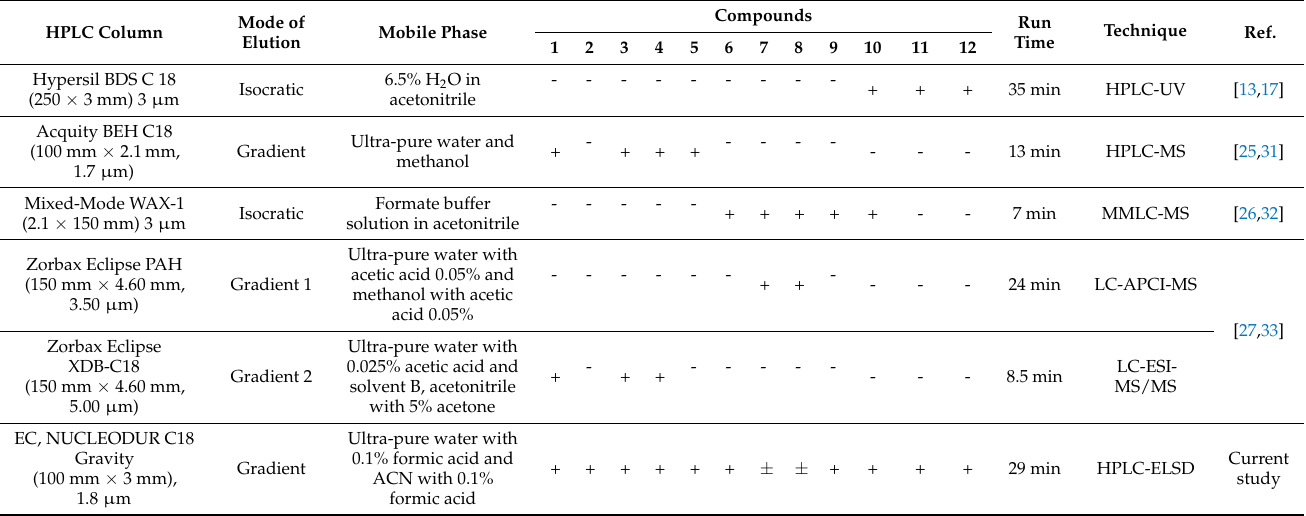
Table 5. Reported HPLC results of flavonoids, sterols, and triterpenes separation, and a comparison with the current study. HPLC